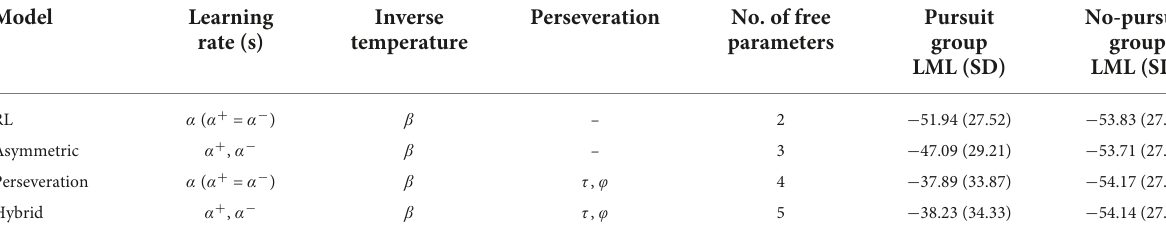
TABLE 1 Models and model selection results.